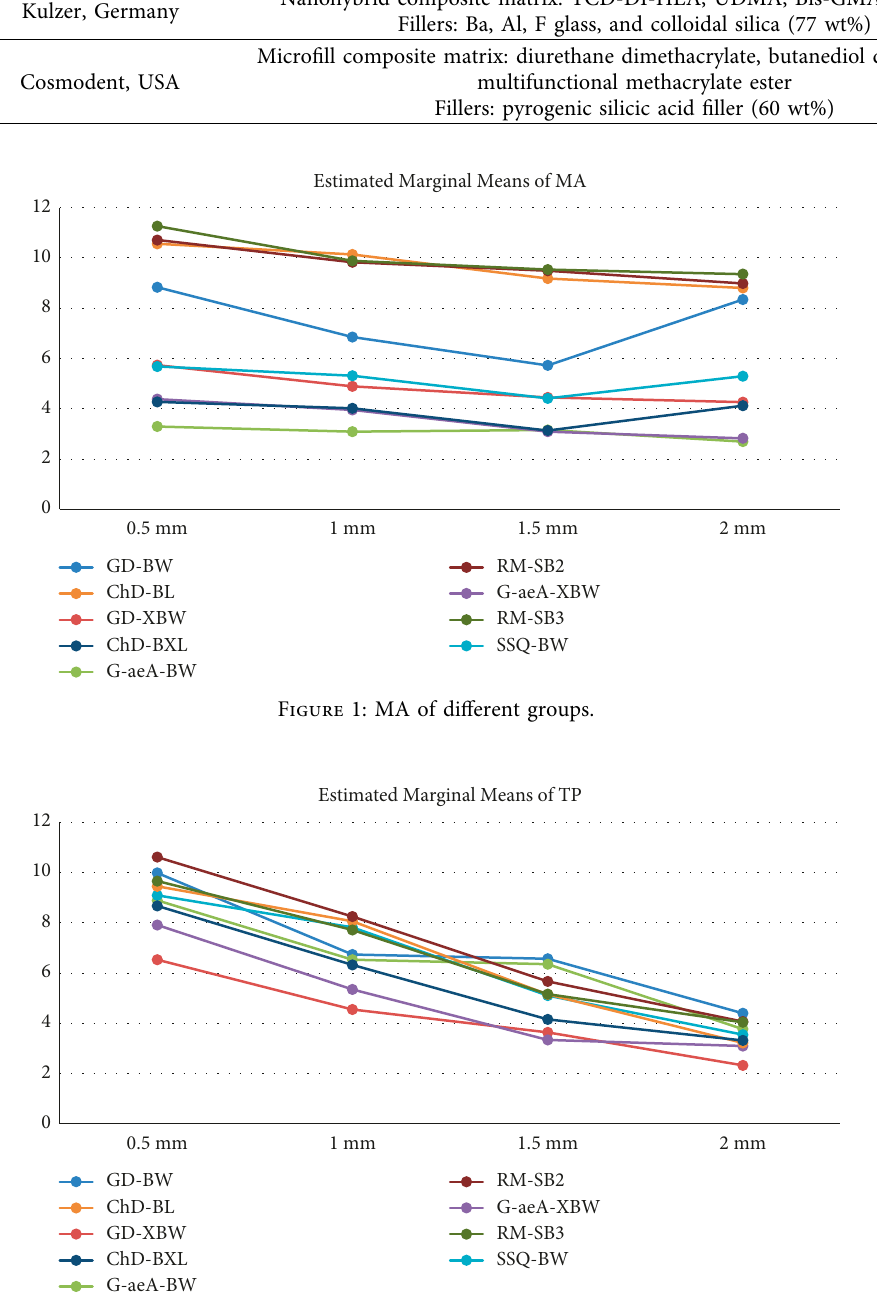
Figure 2: TP of different